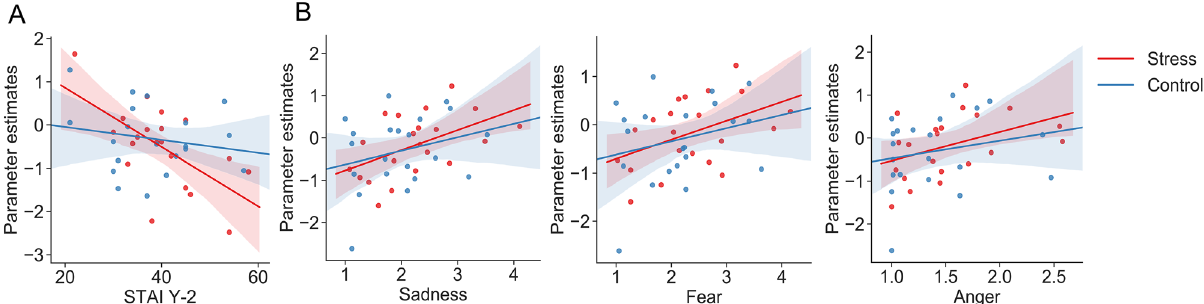
Figure 5. Correlation analysis in the vmPFC and pre-SMA. ( A ) Significant correlation between event-related parameter estimates during the image display period in the vmPFC and the STAI Y-2 (trait anxiety) measured at − 40 min (before the TSST) (r = − 0.62, P = 0.0036). ( B ) Significant correlation plot of event-related parameter estimates during the image display period in the left pre-SMA and the evaluation scores of sadness, fear